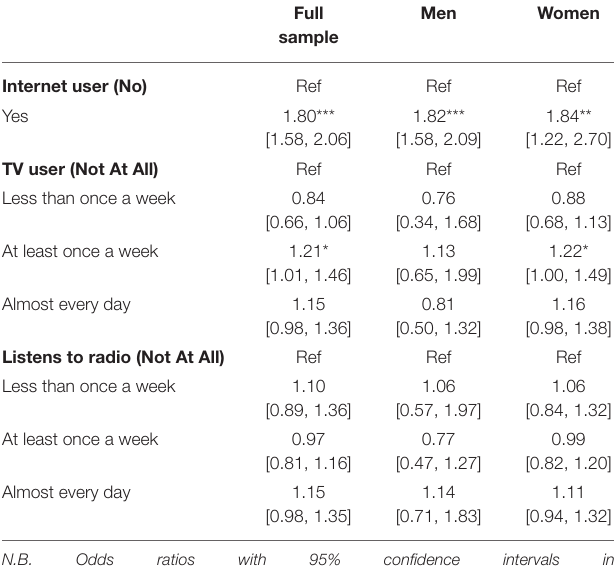
TABLE 3 | Association between electronic media use and alcohol drinking among adult men and women in Guyana